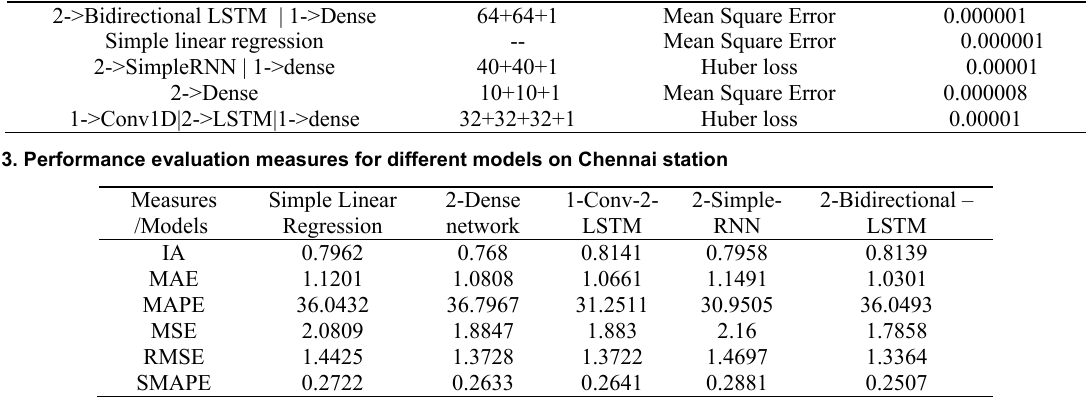
Table 2. Details of the parameter used by the different NN models NN Models